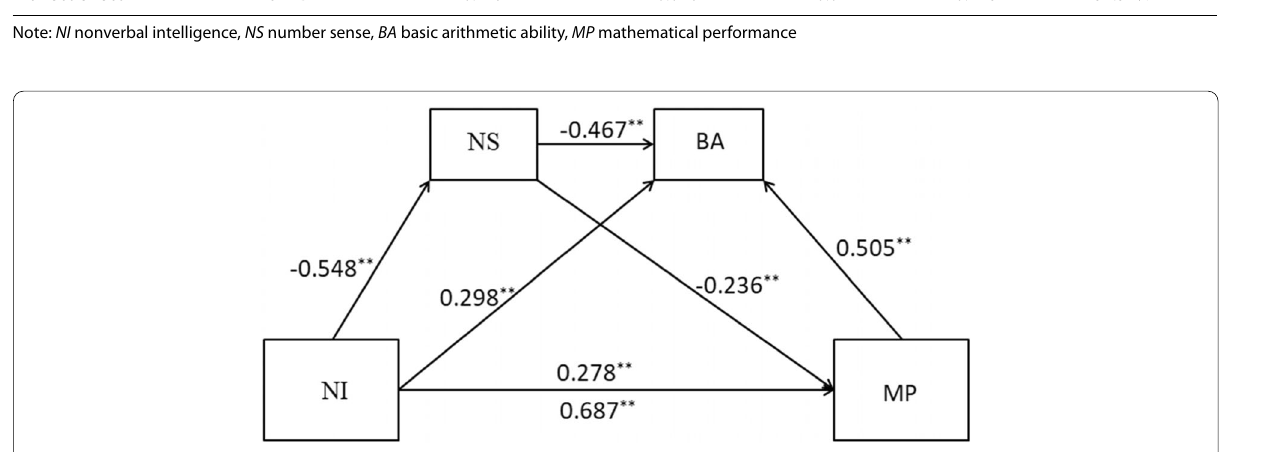
Fig. 1 The chain multiple mediation model. Note: NI, nonverbal intelligence; NS, number sense; BA, basic arithmetic ability; MP, mathematical performance; * p < .05, ** p <